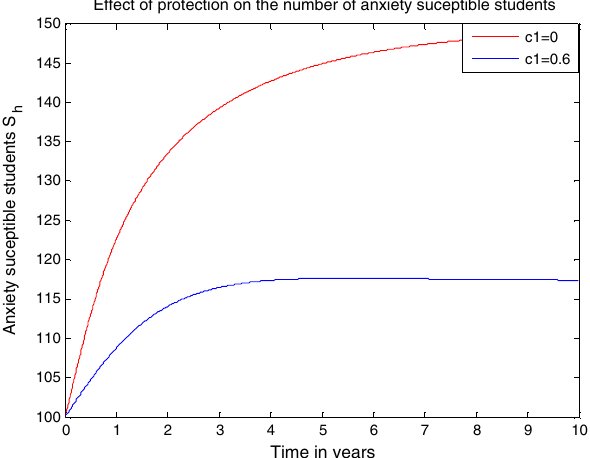
Figure 11. Effect of protection on the number of anxiety susceptible students ( S h ) .